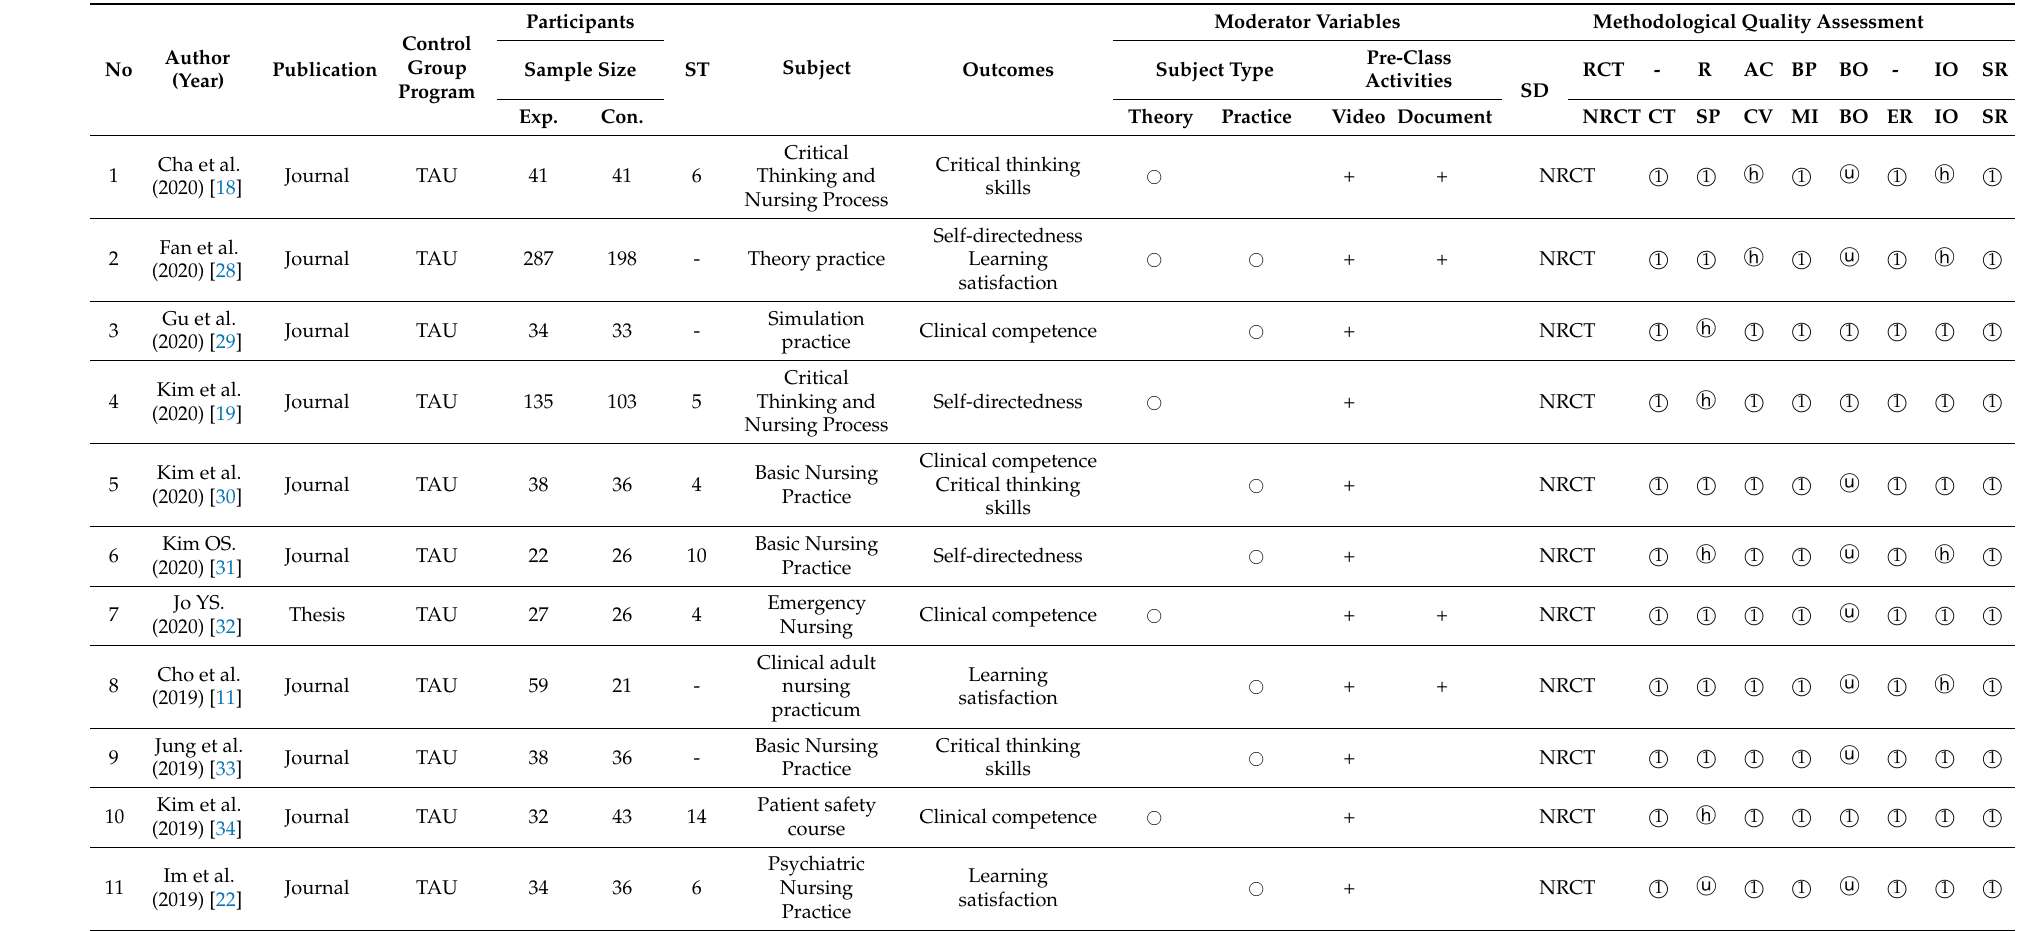
Table 1. Descriptive summary of included studies.